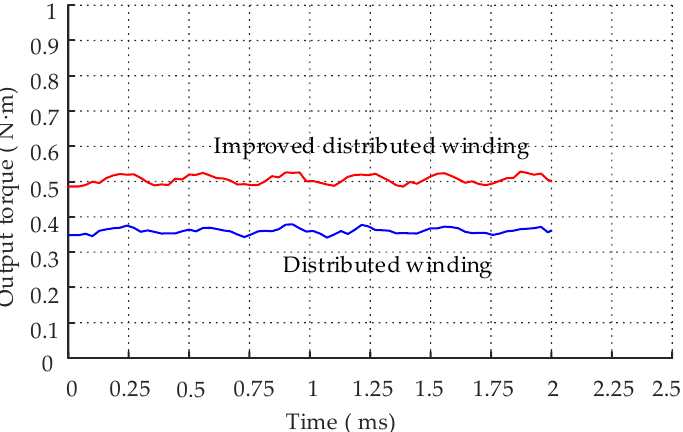
Figure 13. Torque curve with time.